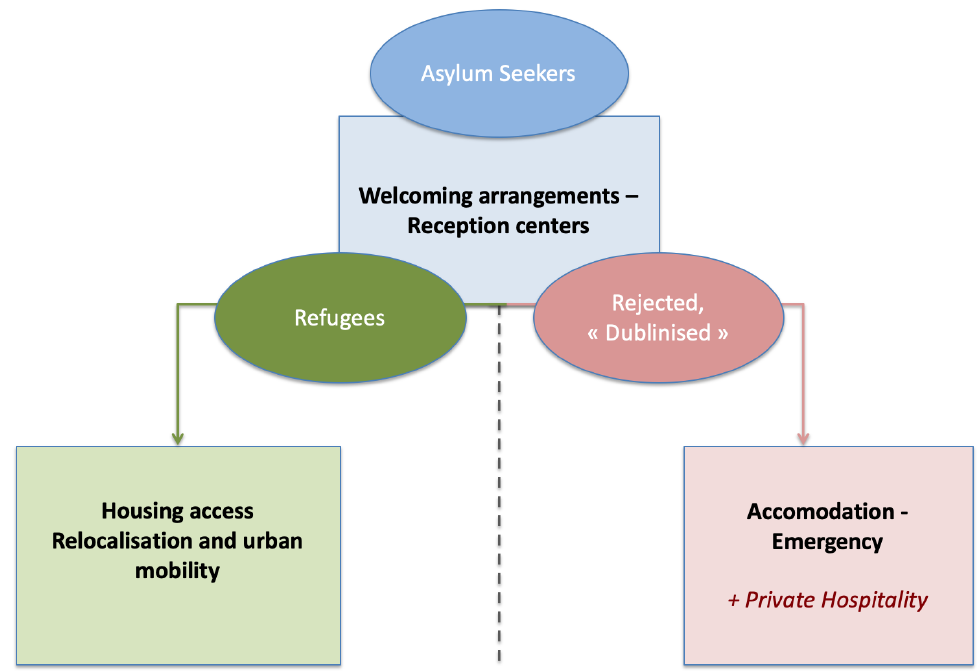
Figure 1. Formal trajectory of an exiled asylum seeker among the various facilities available based on their administrative status. Diagram based on our research fieldwork and DNA